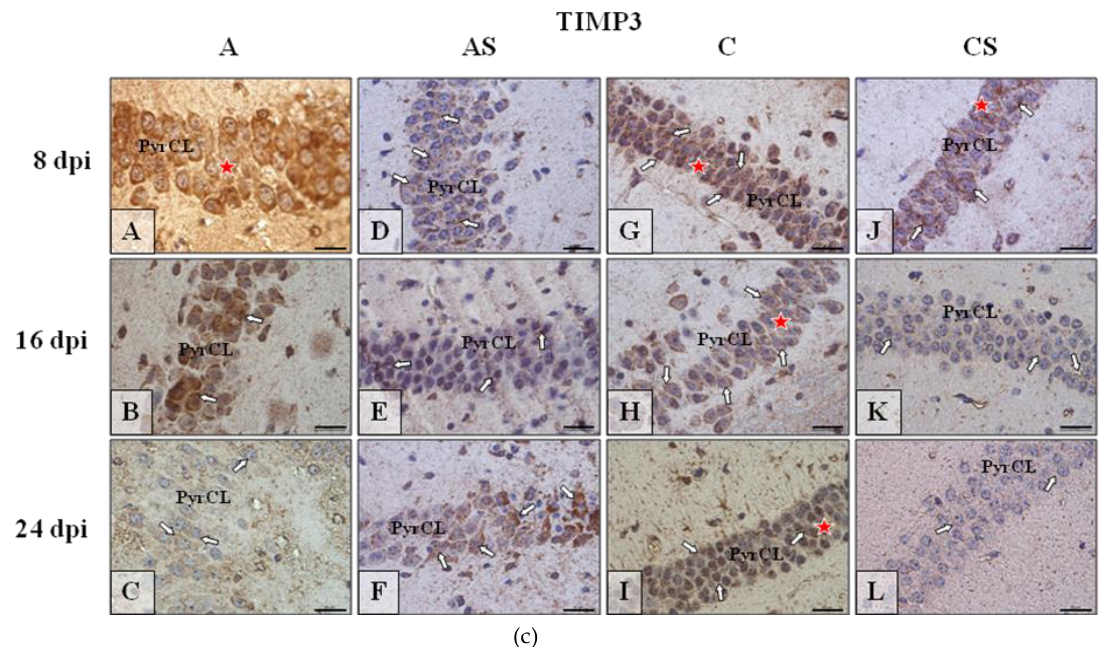
Figure 8. ( a ) Representative microphotography showing immunoexpression (brown color) of tissue inhibitors of metalloproteinase-3 (TIMP-3) in the neocortex of mice from control group (a, G–I), immunosuppressed uninfected control group (a, J–L), immunocompetent infected by Acanthamoeba spp. (a, A–C) and immunosuppressed Acanthamoeba spp. infected group (a, D–F) in 8, 16, and 24 day post infection (dpi). White arrows show immunoexpression of TIMP-3 in neurons of cerebral cortex. ( b ) Representative microphotography showing immunoexpression (brown color) of TIMP-3 in neurons of granular cell layer (GCL) of the gyrus dentatus of mice from control group (b, G–I), immunosuppressed uninfected control group (b, J–L), immunocompetent infected by Acanthamoeba spp. (b, A–C) and immunosuppressed Acanthamoeba spp. infected group (b, D–F) in 8, 16, and 24 dpi. White arrows show immunoexpression of TIMP-3 in neurons of GCL of hippocampus, black arrows show immunoreactivity of big neurons of polymorphic cell layer. Red asterisk (A) shows tendency to immunolocalization of TIMP-3 over the whole thickness of GCL. ( c ) Representative microphotography showing immunoexpression (brown color) of TIMP-3 in the neurons of pyramidal cell layer (PyrCL) of cornu ammonis of mice from control group (c, G–I), immunosuppressed uninfected control group (c, J–L), immunocompetent infected by Acanthamoeba spp. (c, A–C) and immunosuppressed Acanthamoeba spp. infected group (c, D-F) in 8, 16, and 24 dpi. White arrows show immunoexpression of TIMP-3 in neurons of that region of hippocampus. Red asterisks, in some cases (c, A,G–J), shows tendency to immunolocalization of TIMP3 over the whole thickness of GCL.Objective magnification a – c : ×100. Scale bar = 20μm.